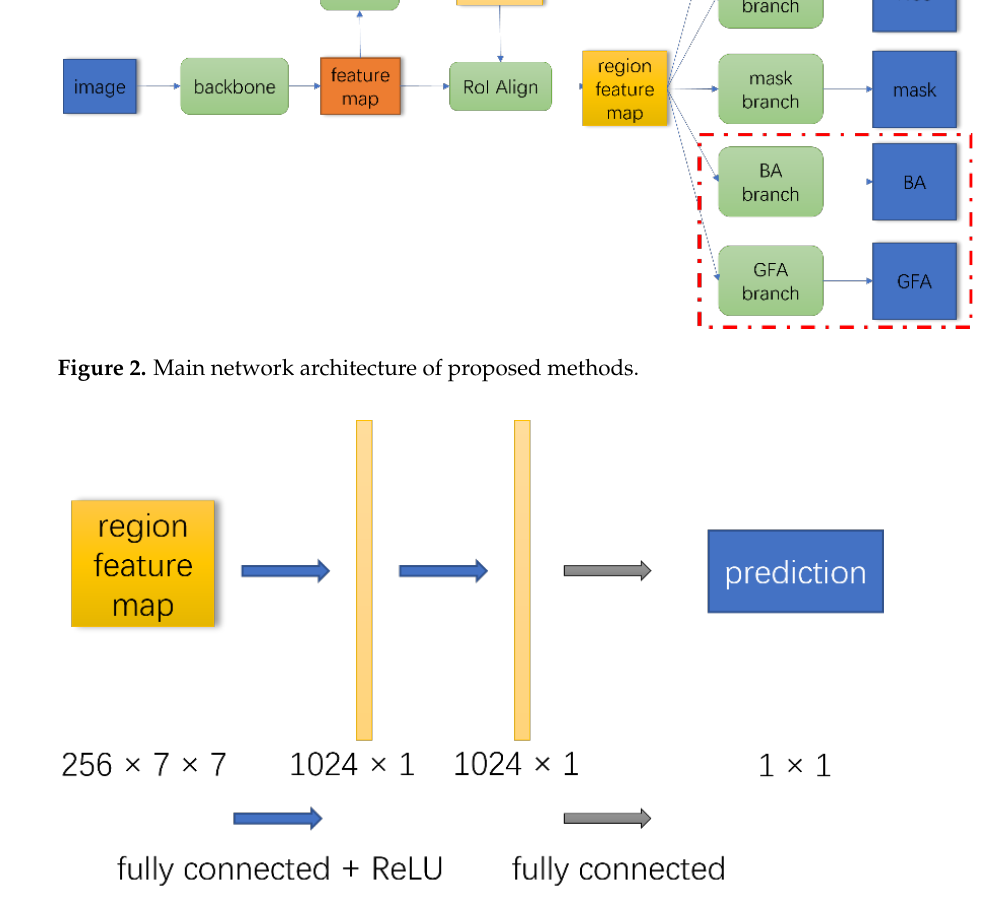
Figure 3. Network architecture of BA branch and GFA branch. This figure is from [3].